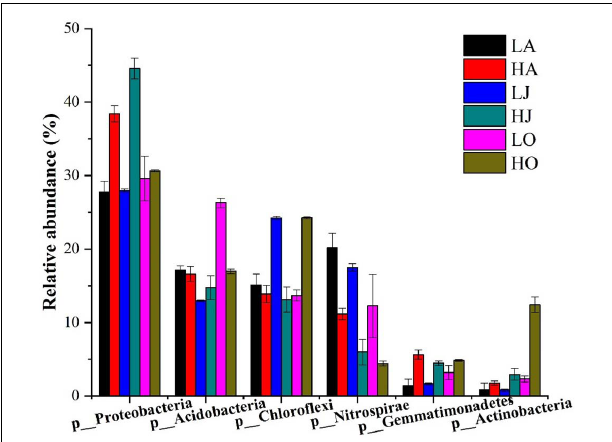
FIGURE 2 | Community composition of dominant bacterial phyla for six samples of different Cd concentrations (LA: 0.46 mg/kg; LJ: 0.36 mg/kg; LO: 0.39 mg/kg; HA: 27.11 mg/kg; HJ: 53.70 mg/kg; HO: 8.52 mg/kg). The relative abundances of Proteobacteria (HA:38.4%, LA:27.77%; HJ:44.59%, LJ:27.98%; HO:30.65%, and LO:29.60%) and Gemmatimonadetes (HA:5.62%, LA: 1.41%; HJ:4.48%, LJ:1.69%; HO:4.82%, and LO:3.21%) at the site H were higher than that of site L, whereas the abundance of Nitrospirae (HA: 11.16%, LA: 20.17%; HJ: 5.98%, LJ: 17.49%; HO: 4.43%, and LO: 12.28%) at the site H was lower than that of site